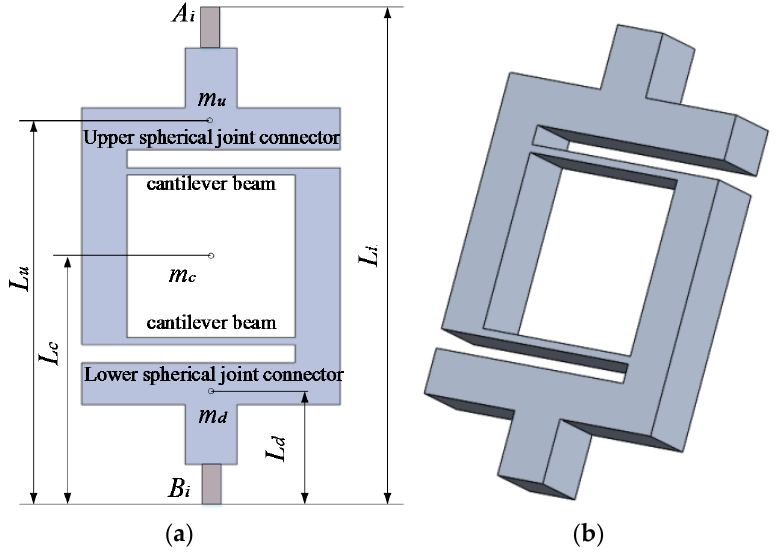
Figure 2. Structure of the elastic leg. ( a ) Front side of the elastic leg; ( b ) 3D model of the elastic leg.